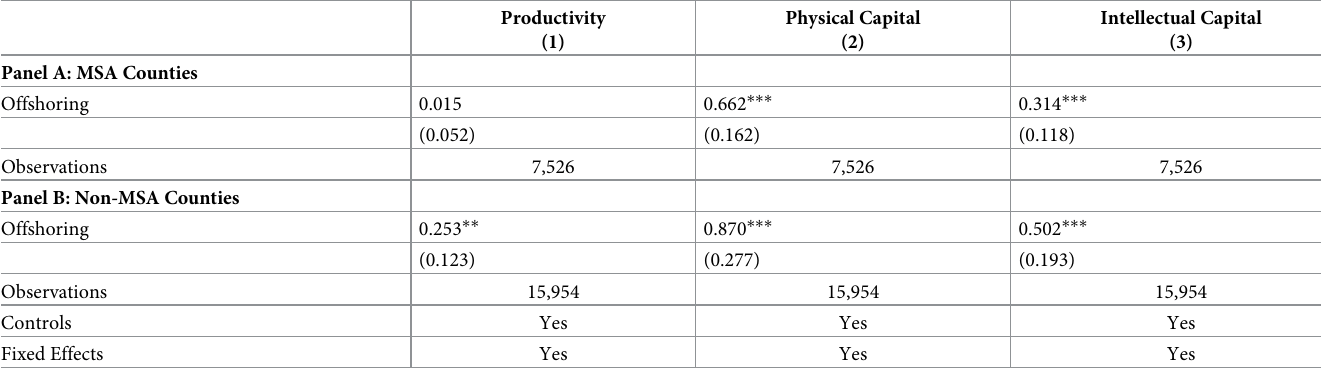
Table 3. Offshoring effects on productivity and capital investment by